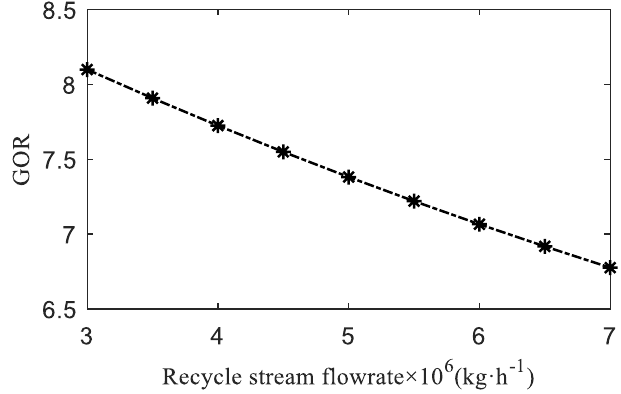
Figure 13. E ff ect of recycle stream flowrate ( W Re ) on Figure 13. Effect of recycle stream flowrate ( Re W ) on GOR.